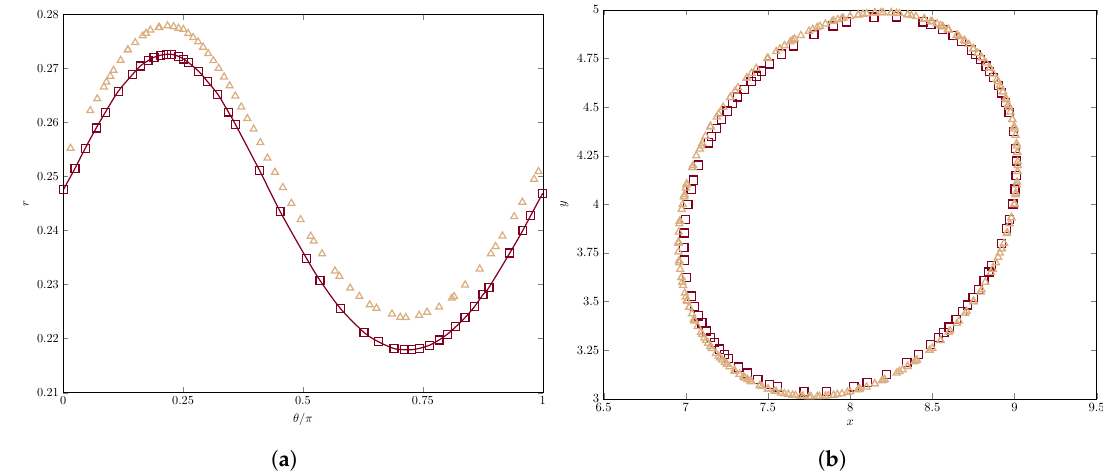
Figure 4. Comparison of the drop shape in ( a ) polar coordinates and ( b ) the actual shape, for Ca = 0.1, between our results (triangles) and those found in Yue et al. [22] (square